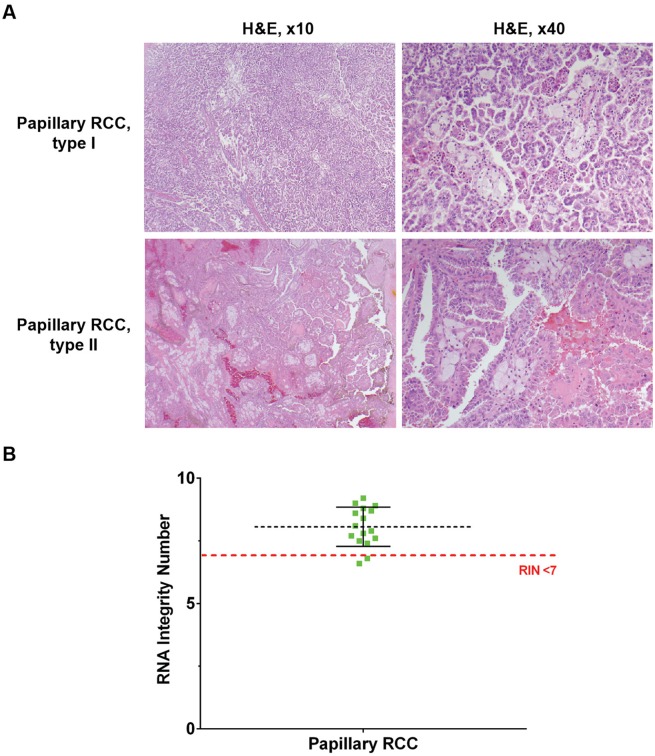
Papillary Renal Cell Carcinoma (RCC) Samples Submitted to The Cancer Genome Atlas (TCGA).A, Representative mirror images of top slides sent for independent pathology review to the Biospecimen Core Resource of TCGA. H&E indicates hematoxylin-eosin stain; original magnification ×10 (left) and ×40 (right). B, Scatterplot of TCGA quality assessment of RNA processed from papillary RCC specimens. The black horizontal dotted line represents the mean, with the vertical error bars representing the SD. RNA integrity numbers (RINs) were assessed by TCGA RNA bioanalyzer. Two samples with RIN <7 were disqualified.